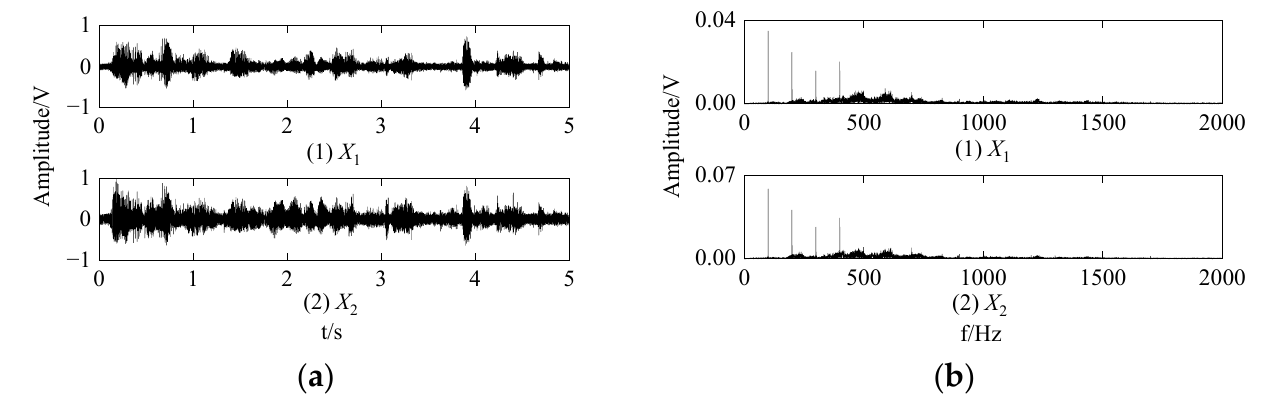
Figure 5. Waveforms and spectrums of the mixed acoustic signals; (( a ): waveforms; ( b ): spectrums.).